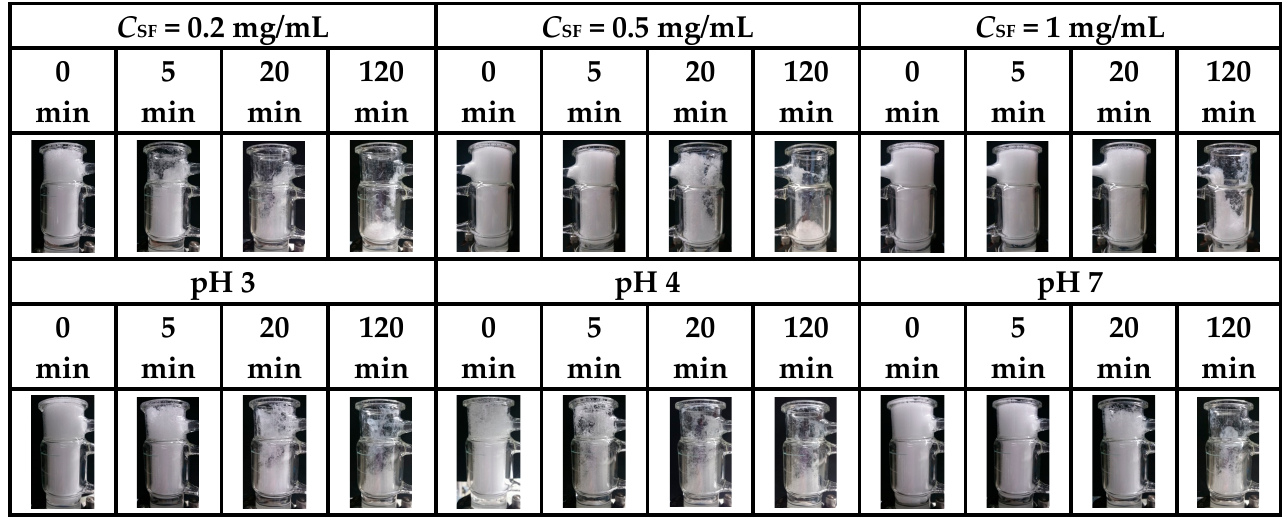
Figure 8. Photographs of foams fabricated by SF aqueous solutions with different C SF and by 0.2 mg/mL SF buffer solutions at different pH taken at different times immediately after foam preparation (taken from [34,35]).